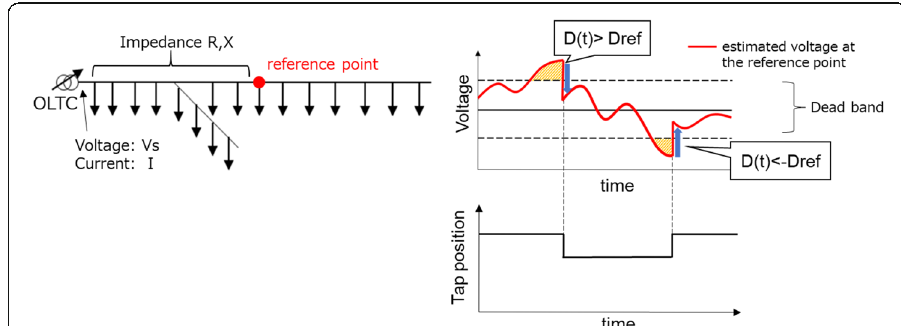
Fig. 1 Tap control scheme of vector LDC